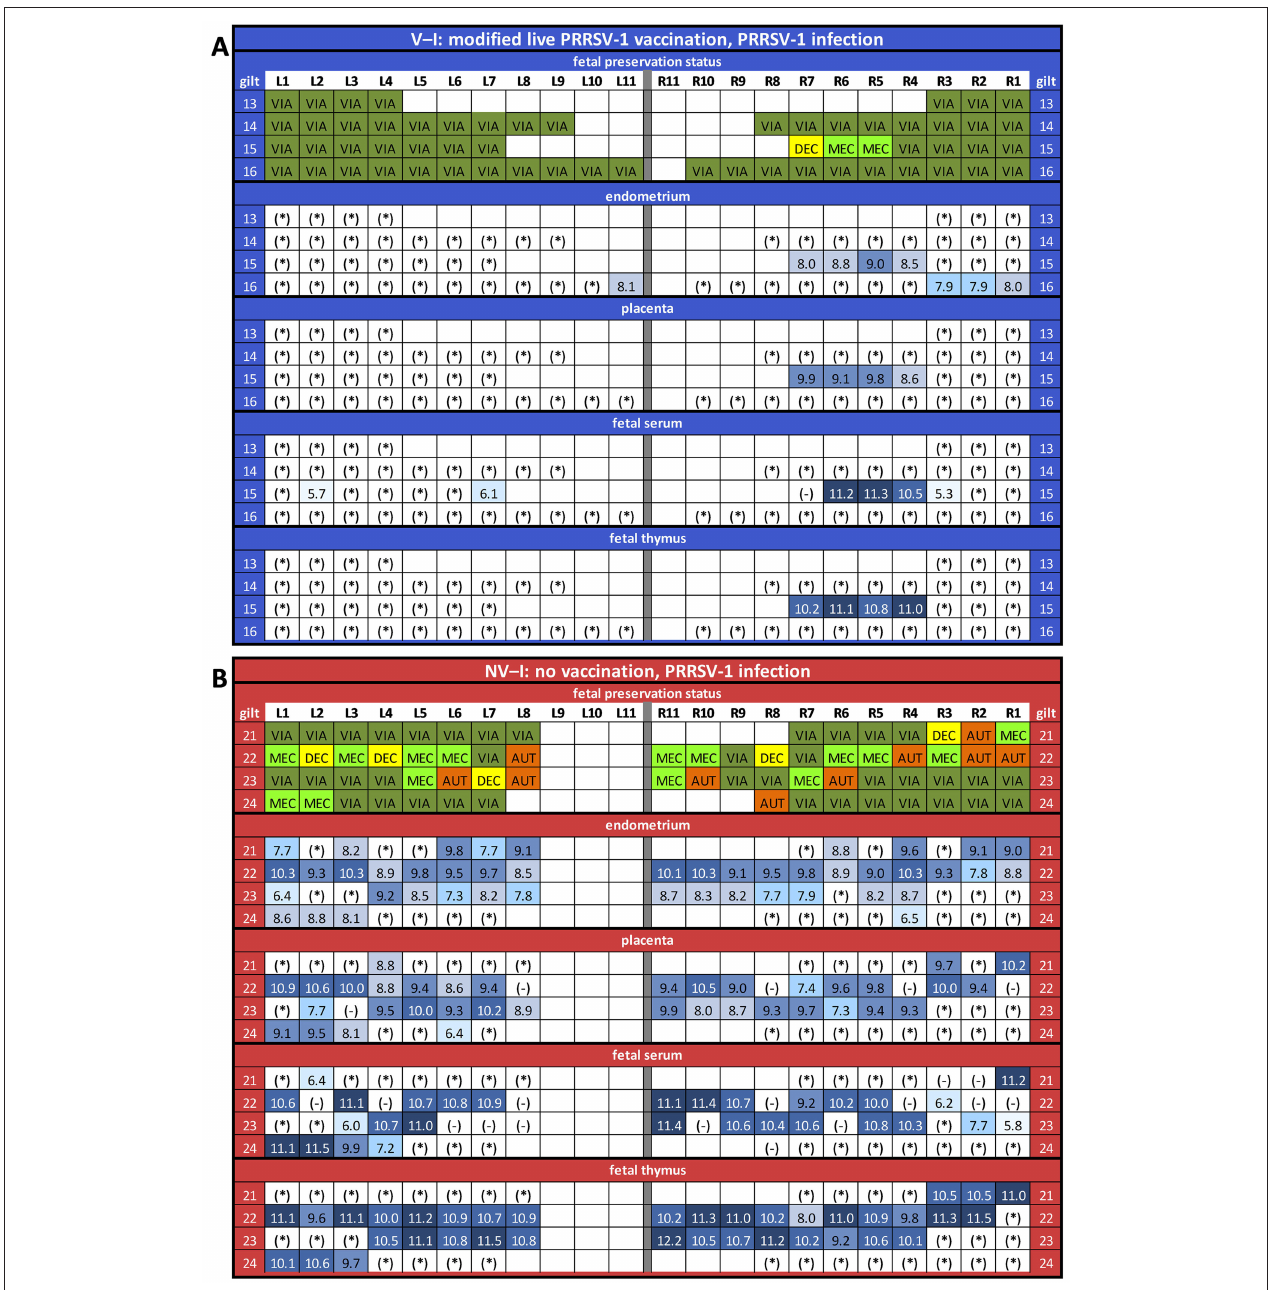
FIGURE 7 | Fetal preservation and porcine reproductive and respiratory syndrome virus-1 AUT15-33-specific RT-qPCR results in fetal samples collected at necropsy (presented as log 10 -transformed genome equivalents per gram of tissue or milliliter of serum) for the vaccinated and infected (V–I) gilts (A) and for the non-vaccinated and infected (NV–I) gilts (B) . The fetuses were numbered according to their location in the uterus, with the ones closest to the ovary being “L1” in the left horn and “R1” in the right horn. Each line represents one litter. For the fetal preservation, colors represent the different categories (viable in dark green, meconium-stained in light green, decomposed in yellow, and autolyzed in orange). For the RT-qPCR results, colors represent the number of genome equivalents per gram of tissue or milliliter of serum (light blue to dark blue). *, below detection limit; -, not sampled. The RT-qPCR results are presented for the endometrium, fetal placenta, fetal serum, and fetal thymus of each